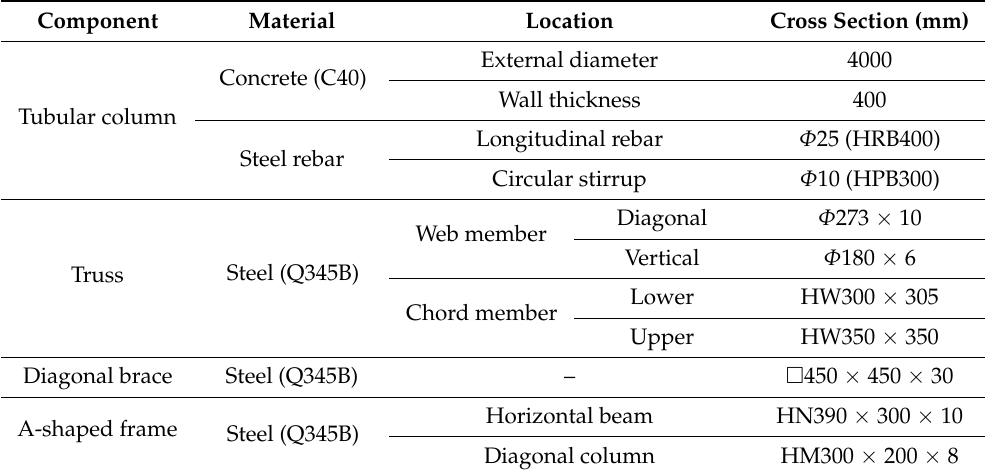
Figure 2. Structural layouts of prototype structure (unit: mm): ( a ) Plan layouts of columns; ( b ) Elevation view along the A-shaped frame direction; ( c ) Elevation view perpendicular to A-shaped frame direction. Table 1. Cross sectional properties of structural components.